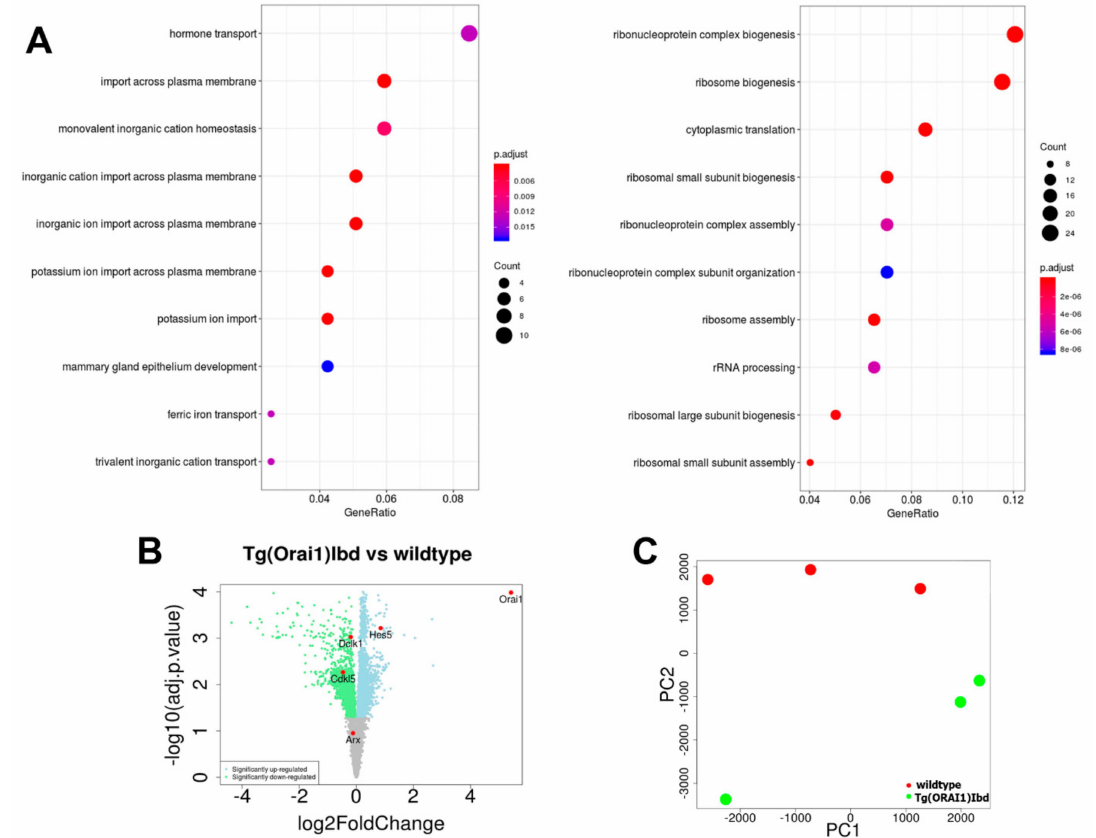
Figure 2. RNA sequencing (RNAseq) analysis using Noiseq tools based on data gathered from hippocampi of wild-type and FVB / NJ-Tg(ORAI1)Ibd females. ( A ) Dot plot of Gene Ontology Biological Process groups (GO BP), which are down-regulated and up-regulated in transgenic line (on the left and right, respectively). ( B ) Volcano plot represents di ff erential gene expression between the tested variants. ( C ) Principal component analysis (PCA) of principal component 1 (PC1) and 2 (PC2). Transgenic and wild-type mice are color-coded in green and red, respectively. PCA analysis was carried out from FPKM (Fragments Per Kilobase Million) normalized RNAseq data using prcomp function in R software. 2.3. Validation of RNAseq Data Using Customized Real-Time PCR Assays and ddPCR Technique Indicates Di ff erential Expression of Dclk1, Cdkl5, and Arx Genes in the Hippocampi of Tg(ORAI1)Ibd Females We next performed real-time PCR analysis to verify the RNAseq data using customized arrays designed for the 23 genes that are listed in Table